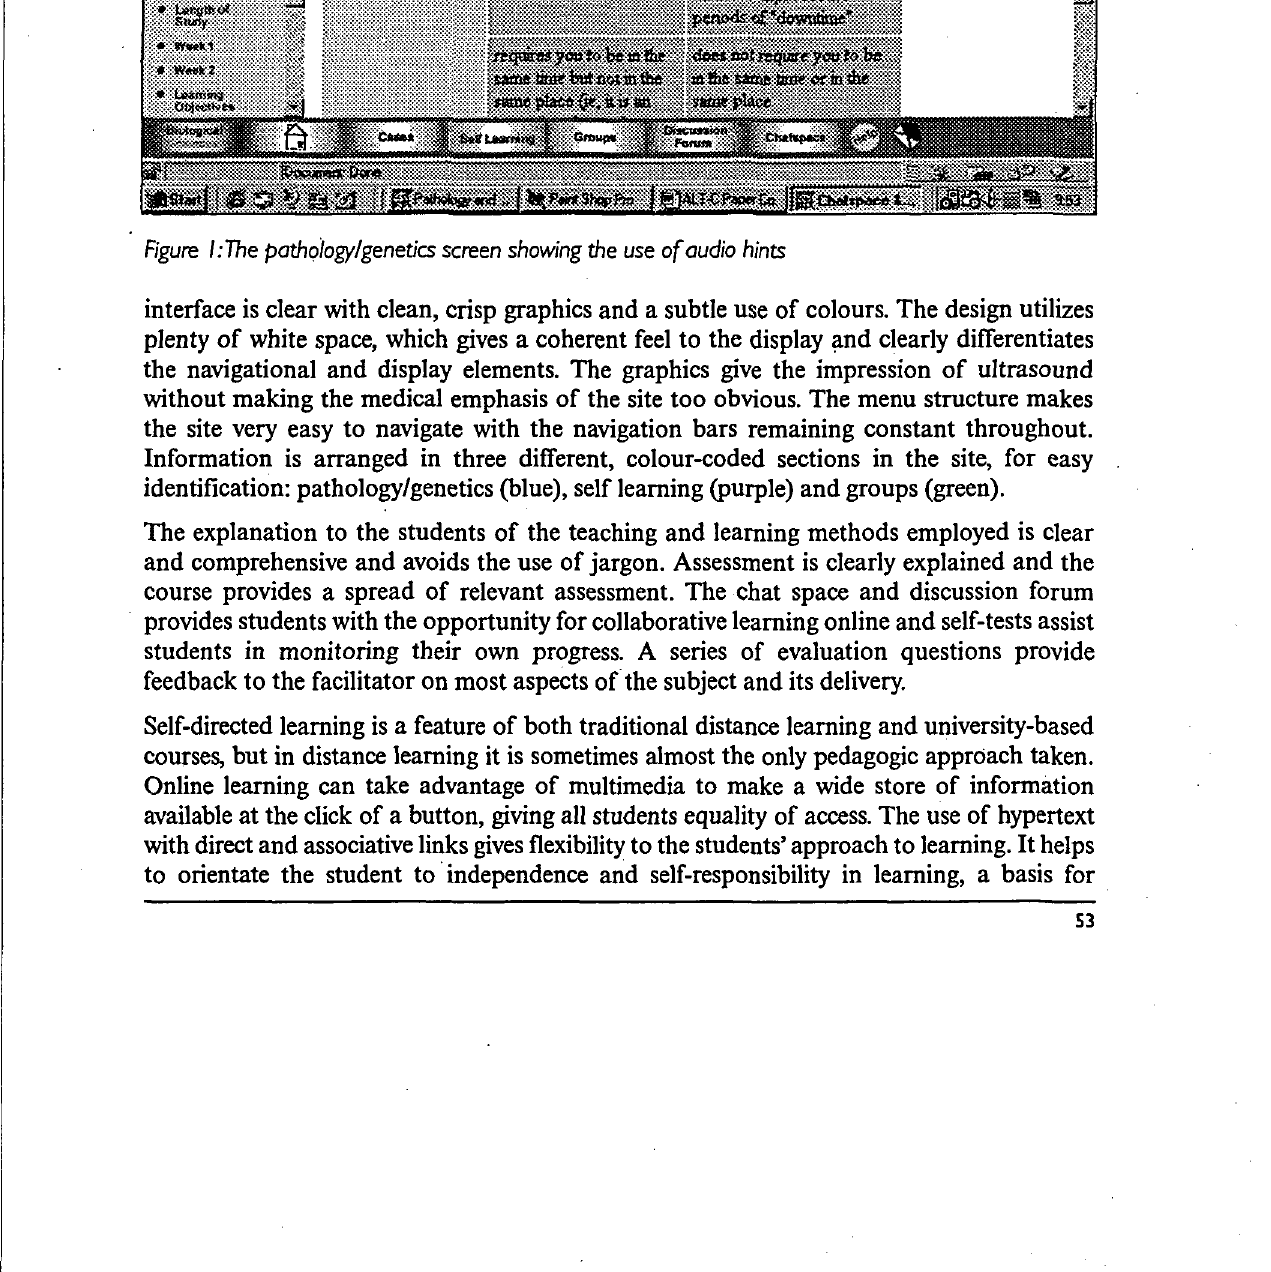
For instructions on how to use the Chatspace and Discussion Forums, cEck on the Help area at the bottom of the screen.